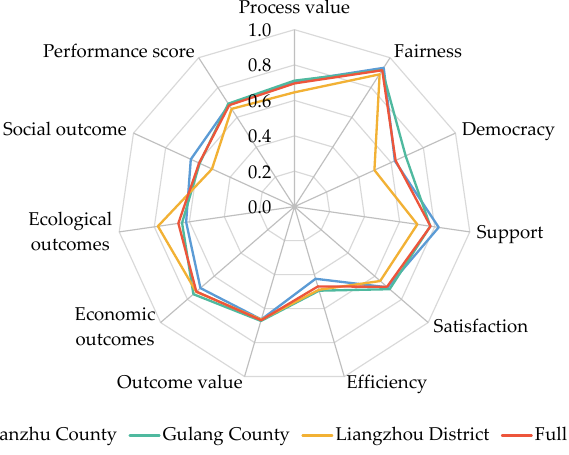
Figure 6. The evaluation results of the FUZZY-TOPSIS. Fairness and efficiency are the two basic values of government public service perfor- mance evaluation [36], which have the highest and lowest performances in the ERP process dimension. The average closeness is 0.916 and 0.470 (Figure 6). The frequency distribution shows 91.60% and 57.25% of eco-migrants’ fairness and support are higher than 0.8, while only 8.40% and 3.82% are below 0.3 (Figure 7). Fairness, as a public service internal